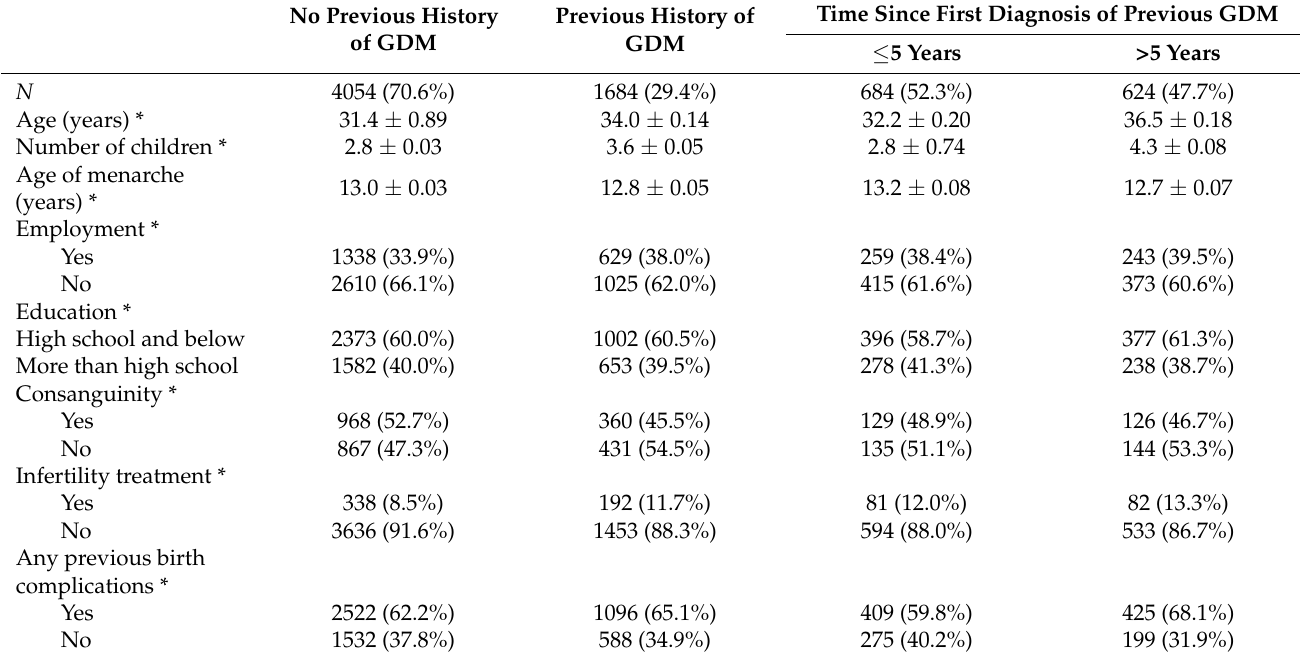
Table 1. Characteristics of 5738 pregnant women by history of previous gestational diabetes mellitus (GDM) status in Al Ain, UAE. The Mutaba’ah